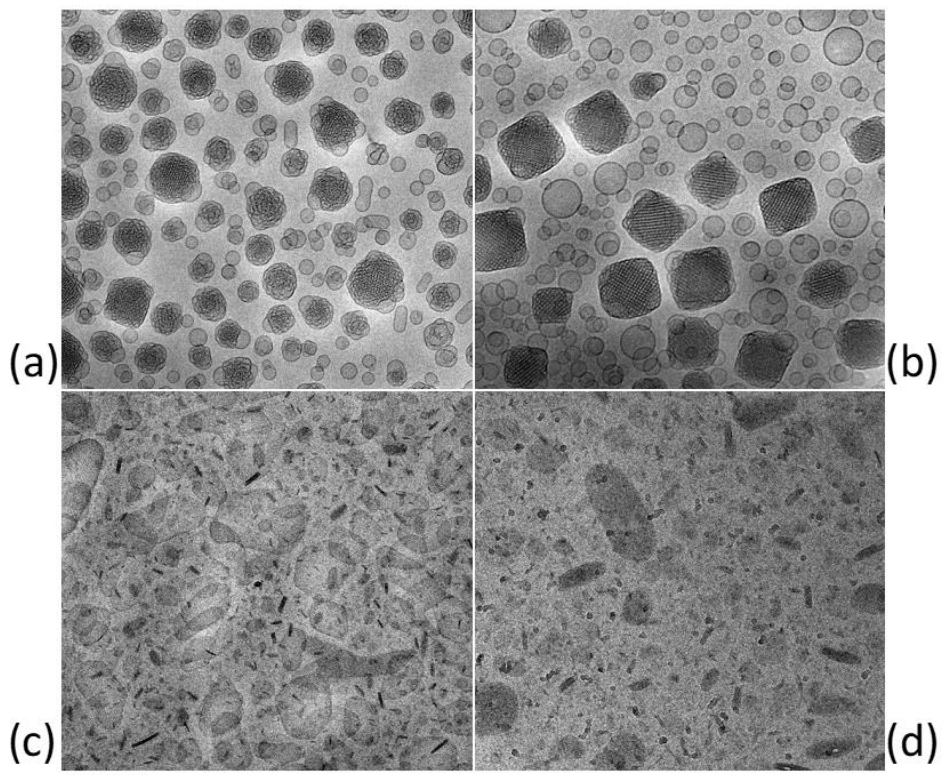
Figure 5. Cryo-TEM images of exemplary LBNs cited in this review: ( a ) MADs; ( b ) cubosomes; ( c ) SLNs; ( d ) NLCs. Bar corresponds to 200 nm ( a – c ) or 100 nm ( d